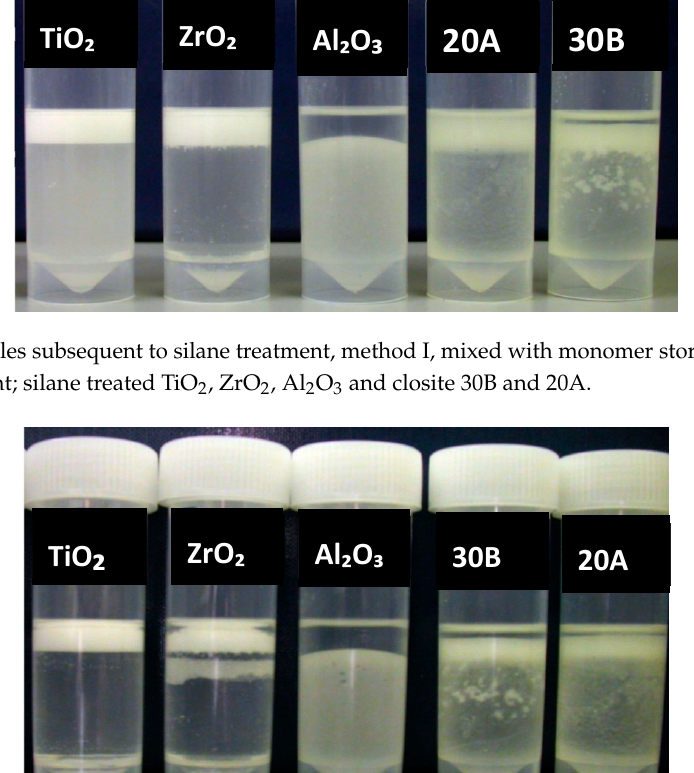
Figure 11. Particles subsequent to silane treatment, method III, mixed with monomer and stored for one hour from left to right; silane treated TiO 2 , ZrO 2 and Al 2 O 3 . 4.2. Biaxial Flexural Strength of Adapted Resins Adding 1 w % of acrylic coated glass flakes improved the BFS of the resin to 146 MPa, SD ± 16 (N = 15) compared with the control group (polymerized plain monomer) which showed 121 MPa, SD ± 12. The difference was statistically significant ( p < 0.05); however, increasing the particle ratio to 2 w % showed less improvement at 131 MPa, SD ± 17, which was not statistically significant ( p > 0.05). Adding 5 w % of particles reduced the BFS of the resin to 106 MPa, SD ± 11, although the difference was not statistically significant ( p > 0.05) (Figure 12 and Table 1). Adding PMMA-silica nanocomposite, silanated A20, B nanoclays, silanated TiO 2 and ZrO 2 reduced the mean BFS of the resin to 100, SD ± 11, 103, SD ± 28, 109, SD ± 31, 113, SD ± 14, 107, SD ± 16 MPa, respectively. However, the differences were not statistically significant ( p > 0.05). Incorporation of silanated closite A93 1 w % and silanated Al 2 O 3 1 w % reduced the mean BFS of the resin to 86, SD ± 9 and 65, SD ± 12 MPa. The differences were statistically significant ( p < 0.05). The mean BFS of 1 w % silanated silica composite was 116 MPa, SD ± 6. In comparison with the control group, the difference was not statistically significant ( p > 0.05). Incorporation of 2, 3 and 5 w % of silanated silica into the resin increased the mean BFS of the resin to 131, SD ± 17, 123, SD ± 10, 126, SD ± 11 MPa. The differences were not statistically significant compared to the control group ( p > 0.05).